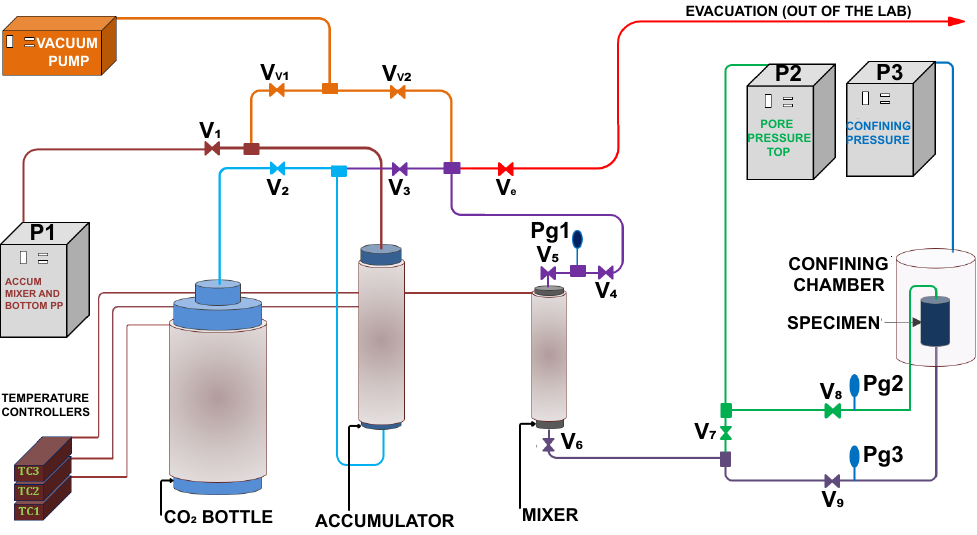
Figure 6. Schematics of the CO 2 flow loop system that was used during the experiment under triaxial conditions. Modified from Agofack et al.